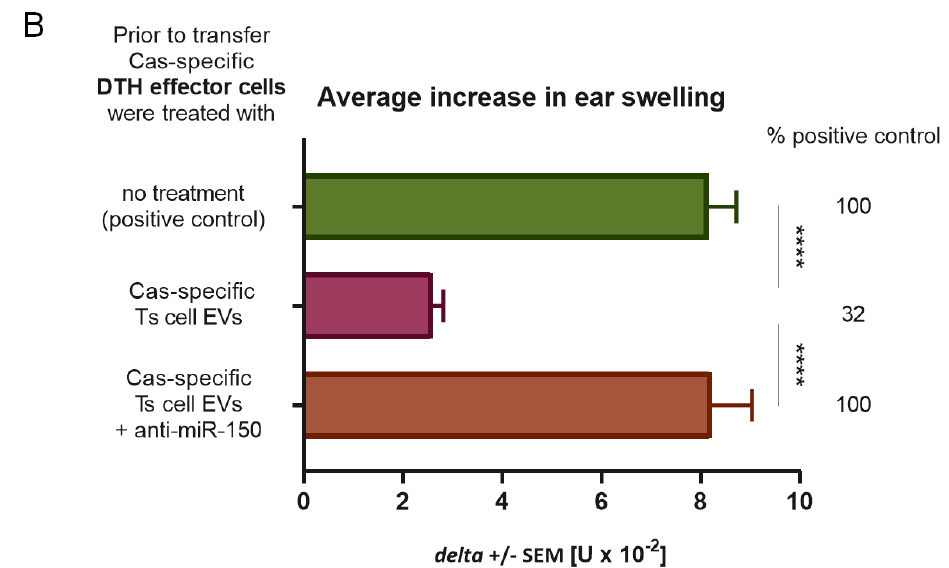
Figure 5. Major histocompatibility complex (MHC) restriction and dependence on miRNA-150 of suppression of delayed-type hypersensitivity (DTH) to soluble casein (Cas) antigen. ( A ) Mice of CBA, BALB/c, or C57BL/6 strains had been intradermally (id) immunized with a saline solution of soluble Cas antigen (100 µg per mouse) 5 days before harvest of lymph nodes and spleens containing effector cells, which were then treated with Cas-specific suppressor T (Ts) cell-derived extracellular vesicles (EVs) of tolerized CBA mice. Afterwards, effector cells were transferred to naive recipients of respective strain, which 24 h later were challenged by id administration of the same Cas solution (5 µg per earlobe). After 24 h, ear swelling response was measured and expressed as delta ± SEM [units (U) × 10 -2 mm] (n = 4, N = 2). ( B ) Part of Ts cell EVs was incubated with miRNA-150 antagonist, i.e. anti-miR-150, prior to treatment of DTH effector cells, which were then adoptively transferred to recipients, challenged 24 h later by id administration of the same Cas solution (5 µg per earlobe). After 24 h, ear swelling response was measured and expressed as delta ± SEM [units (U) × 10 -2 mm] (n = 5, N = 3). **** p < 0.0001.